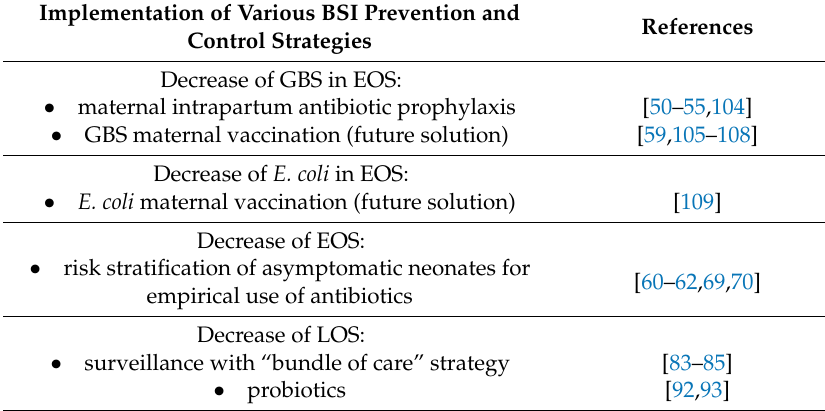
Table 6. Potential interventions in early- and late-onset neonatal sepsis prevention and